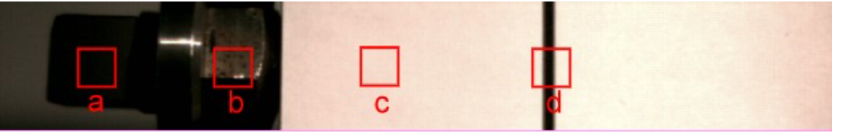
Figure 14. Image with and without white sheet paper. The squares a and b enclose different parts of the accelerometer and the squares c and d contain locations of the white paper with and without the black straight line.